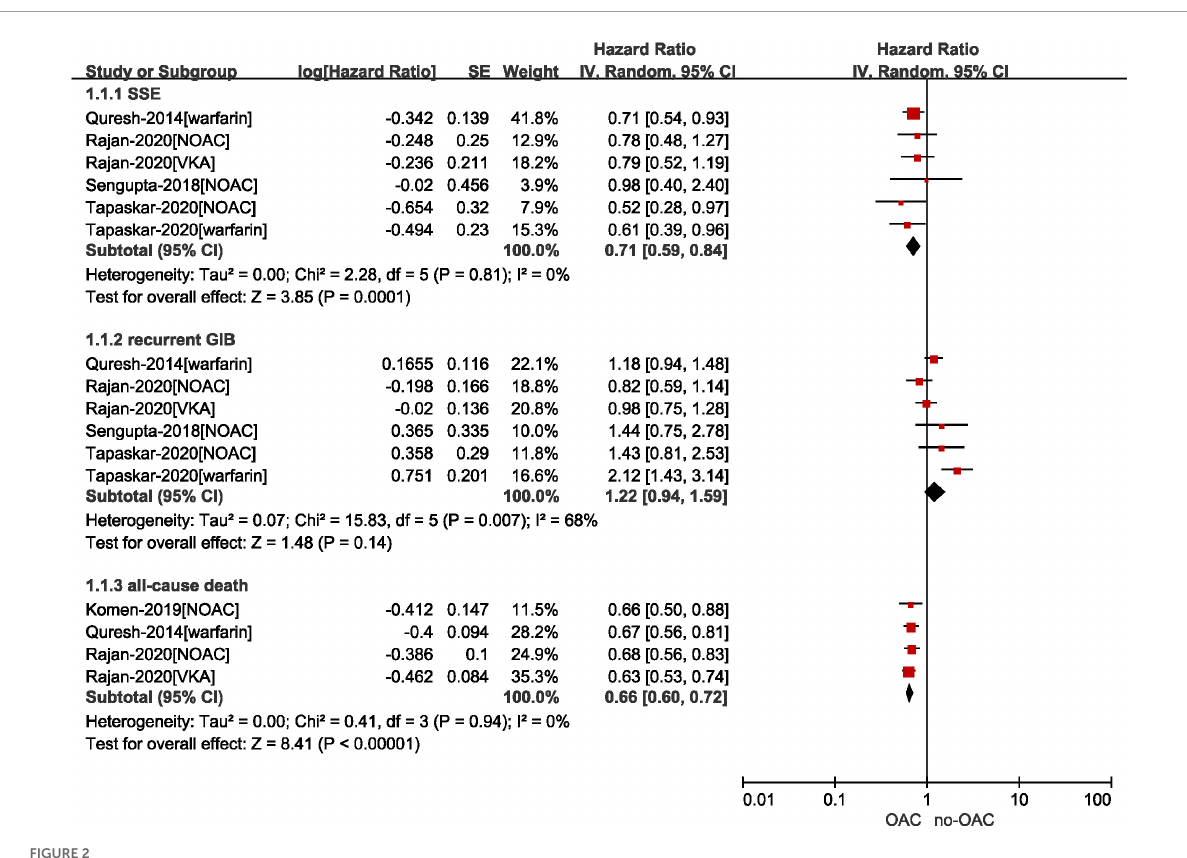
FIGURE2 Comparing the effect of OAC with no OAC in AF patients with GIB. AF, atrial fibrillation; GIB, gastrointestinal bleeding; OAC, oral anticoagulants; NOAC, non-vitamin K antagonist oral anticoagulants; CI, confidence interval; IV, inverse of the variance; SE, standard error; SSE, stroke and systemic